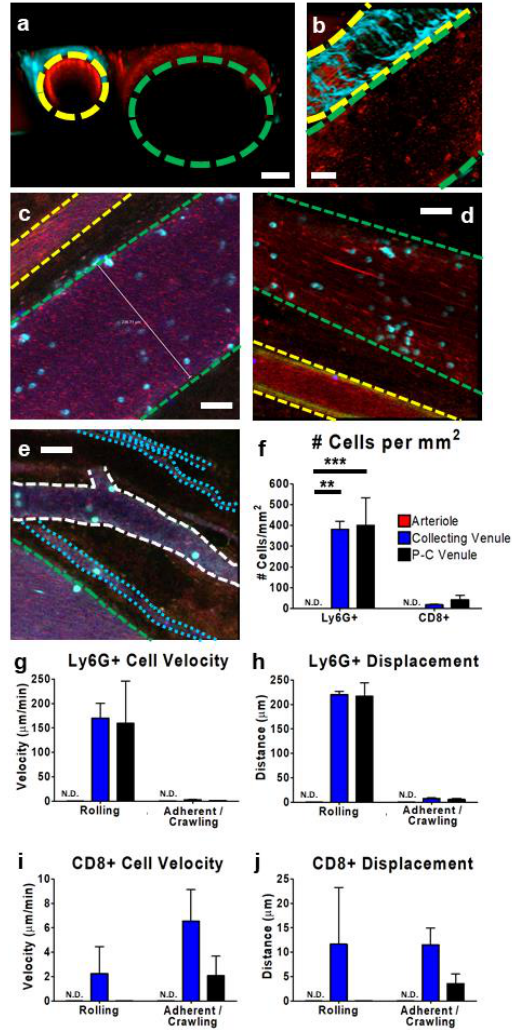
Figure 3. Characterization of tumor vasculature and leukocyte behavior within subcutaneous CT-26 tumor vessels. Representative IVM images ( a – e ) show the tumor vasculature. Using multiphoton imaging ( a , b ), differentiation between arterioles (yellow outline) and collecting venules (green outline) was facilitated by the observation of a collagen sheath (cyan-colored second-harmonic generation) surrounding the arteriole. Vasculature was highlighted by the presence of circulating platelets (red; PE-conjugated anti-CD49b), neutrophils (cyan; BV421-conjugated Ly6G), and CD8+ leukocytes (blue; eFluor 660-conjugated anti-CD8) and was imaged in either cross section ( a ) or transverse section ( b ). Using resonant scanning confocal microscopy ( c – e ), arterioles (yellow outline) were apparent as a result of increased autofluorescence (green) and collecting venules (green outline) were seen as parallel unbranching structures. In contrast, post-capillary venules (P-C venules) were observed as narrower, branching vessels (white outline), and tumor microcirculation/capillaries as very narrow (1–2 cell diameter) vessels (cyan outline) that followed a more convoluted path. Quantification of neutrophil (Ly6G+) and cytotoxic T cell (CD8+) interactions (cells present for ≥ 3 min) within arterioles (red), collecting venules (blue), and post-capillary venules (black) ( f ). Cell velocity ( g , i ) and displacement ( h , j ) of rolling and adherent and crawling neutrophils ( g , h ) and CD8+ T cells ( i , j ), as measured over a 10 min imaging period in a subcutaneous CT-26 tumour; n = 3 animals. Data displayed as the mean ± SEM. Total cell counts normalized for the area of each image occupied by a given vessel type. The white scale bar represents 50 µ m. Statistical significance was determined using ANOVA; ** = p < 0.01; *** = p < 0.001; N.D. = not detected. Images in ( c – e ) were capture using resonant-scanning confocal microscopy, whereas images in ( a , b ) were captured using resonant scanning multiphoton